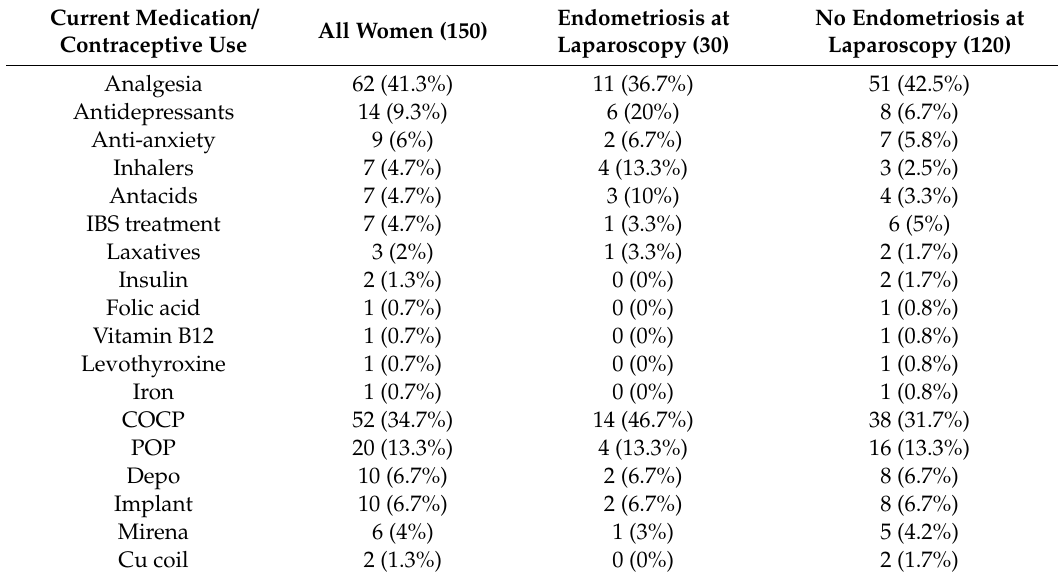
Table 3. Current medication / contraceptive